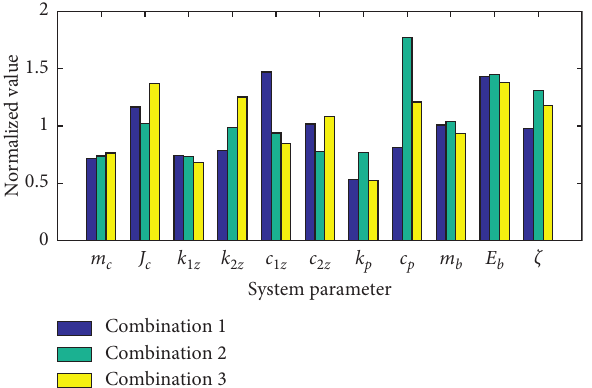
Figure 14: Optimized system parameters based on the imposed screening